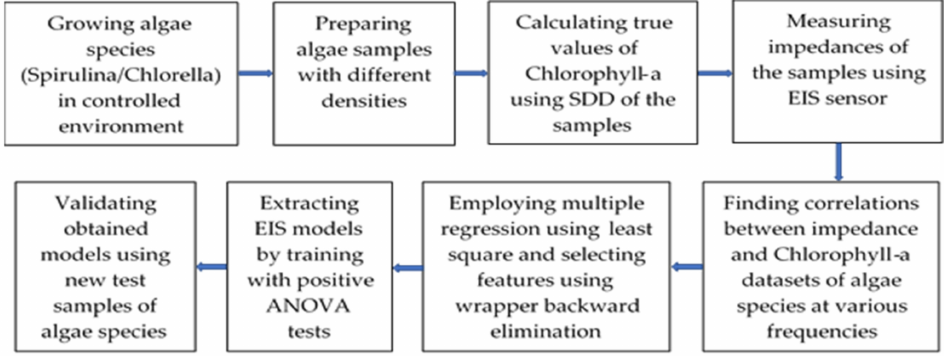
Figure 4. Workflow for the estimation of the Chlorophyll-a of multiple algae species using an EIS sensor